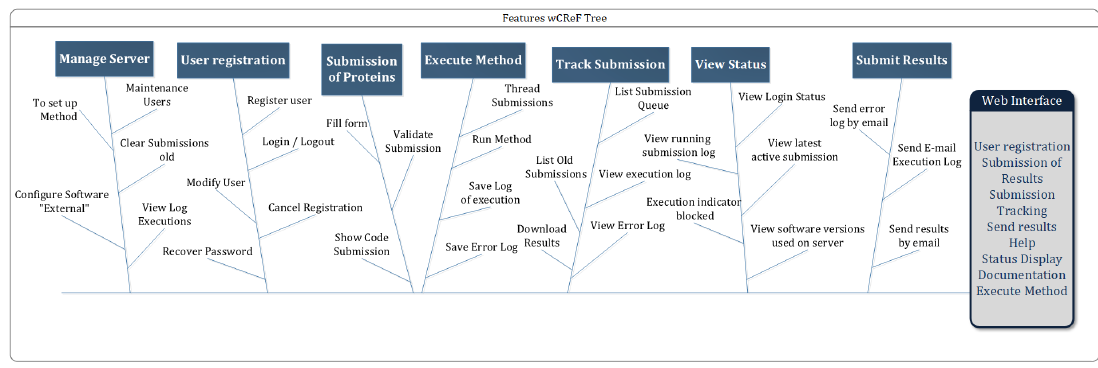
Figure 5. wCReF functional